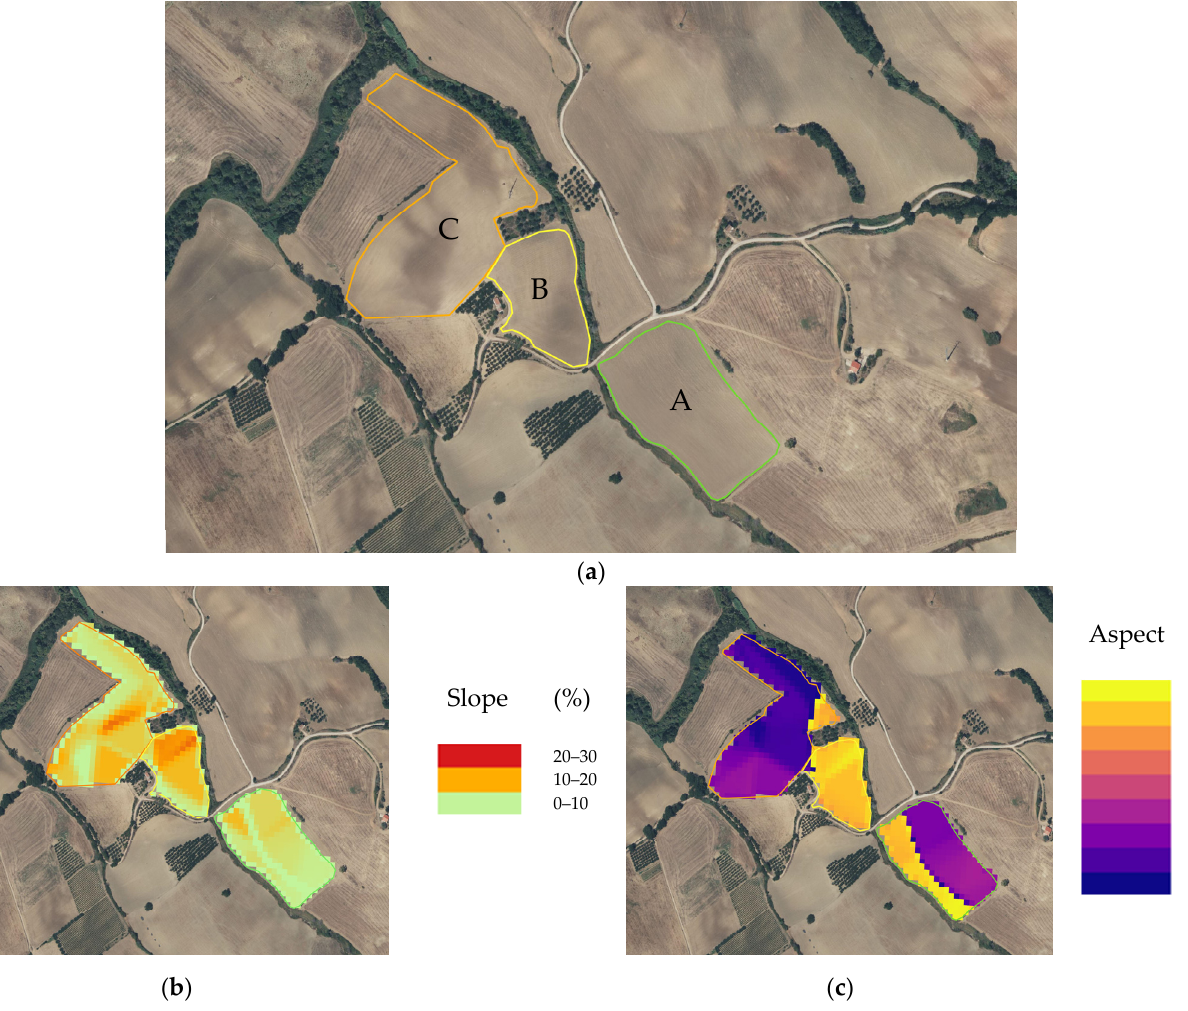
Figure 3. ( a ) Map of subfield areas: A (green boundary), area B (yellow boundary), area C (orange boundary). ( b ) Slope map (%) of the study area. ( c ) Aspect map of the study area was divided into eight directions from north